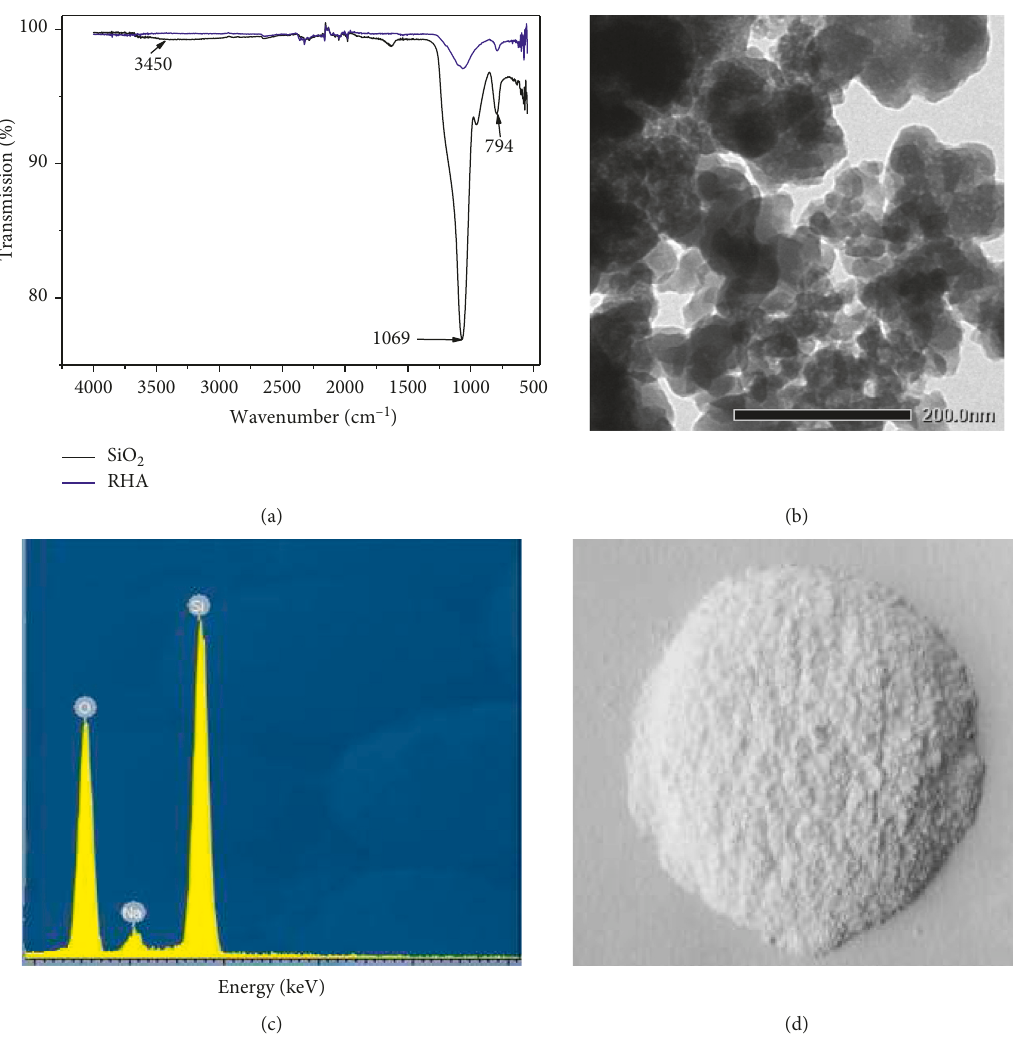
Figure 4: Characterization of SiO 2 extracted. (a) FT-IR spectrum of the RHA and extracted SiO 2 . (b) TEM image of SiO 2 nanoparticles.